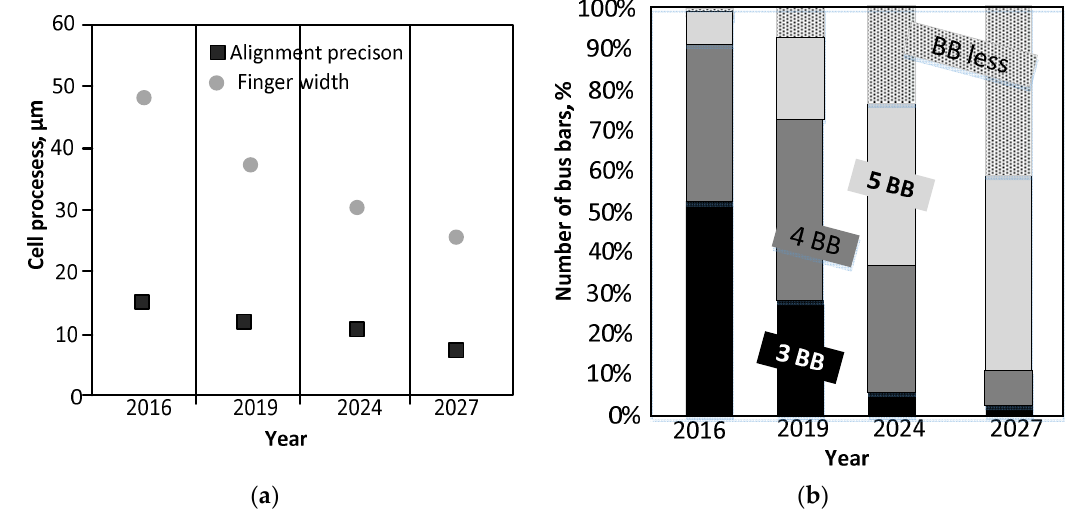
Figure 2. The data of the front line and bus bars electrode concerning the manufacturing process of the Si crystalline solar cells: ( a ) finger width, ( b ) number of bus bars [5].